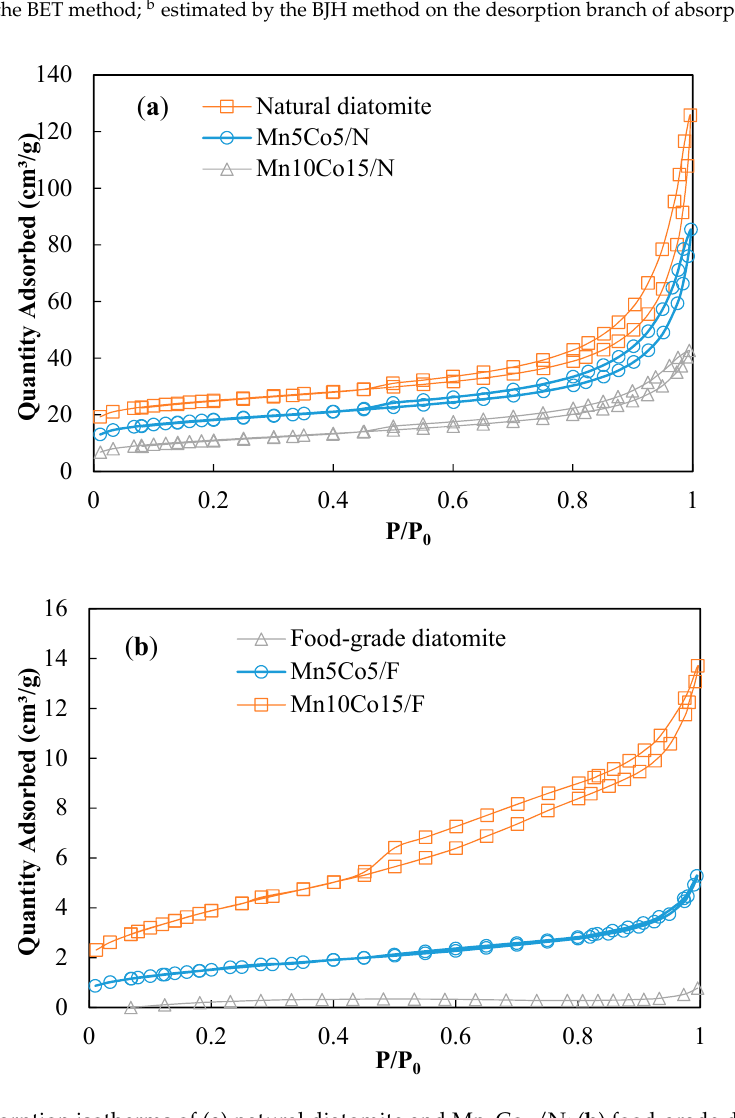
Figure 3. Adsorption isotherms of ( a ) natural diatomite and Mn x Co y /N; ( b ) food-grade diatomite and Mn x Co y /F. Mn x Co y